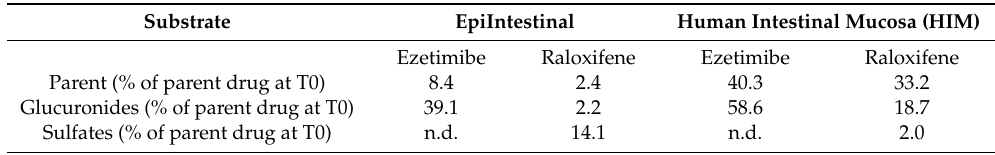
Table 5. EpiIntestinal microtissues and HIM were incubated with 10 µ M ezetimibe or raloxsifene. Metabolite scan was performed as described in “Materials and Methods”. Amount (Peak areas) of parent drugs and metabolites at the end of the incubation was expressed as percent of peak areas of parent drugs at the beginning of the incubation (T0).